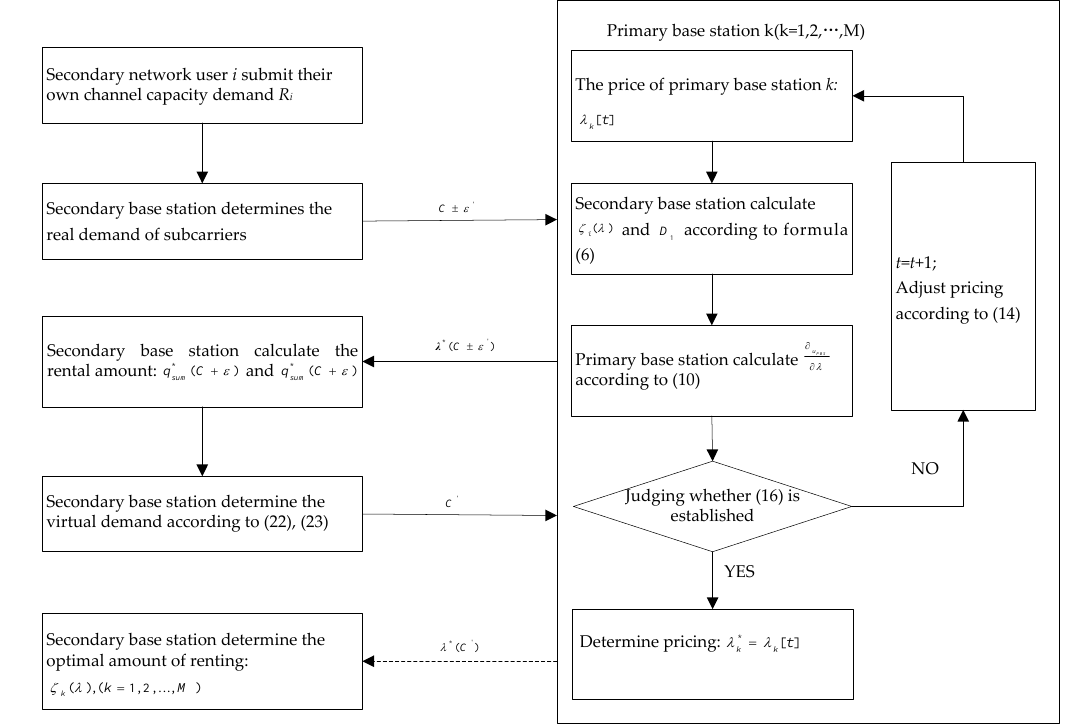
Figure 4. Spectrum pricing and allocation scheduling.